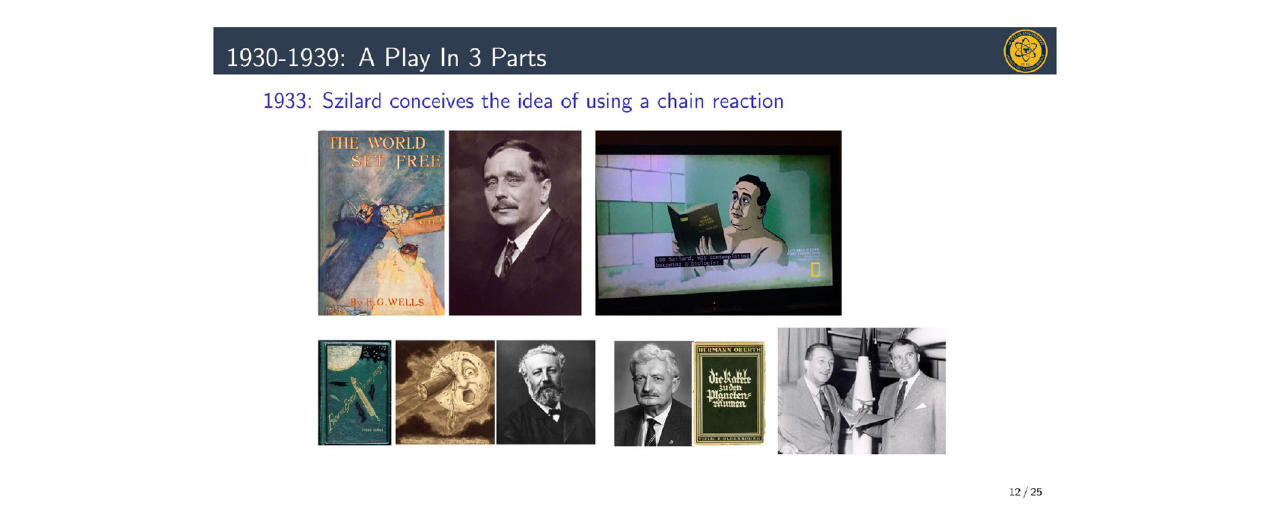
FIGURE9 Slide detailing Leo Szilard’s conceiving of a nuclear chain reaction following insight from H. G. Well’s The World Set Free Similar scientific insights from adjacent disciplines also shown. Lecture